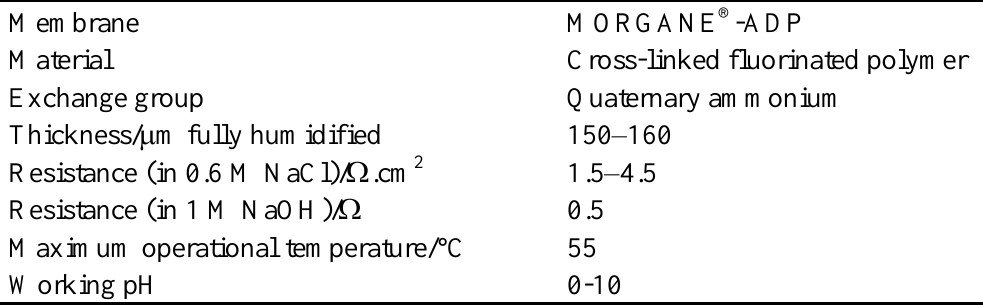
Table 3. Basic properties of the MORGANE ® -ADP membrane